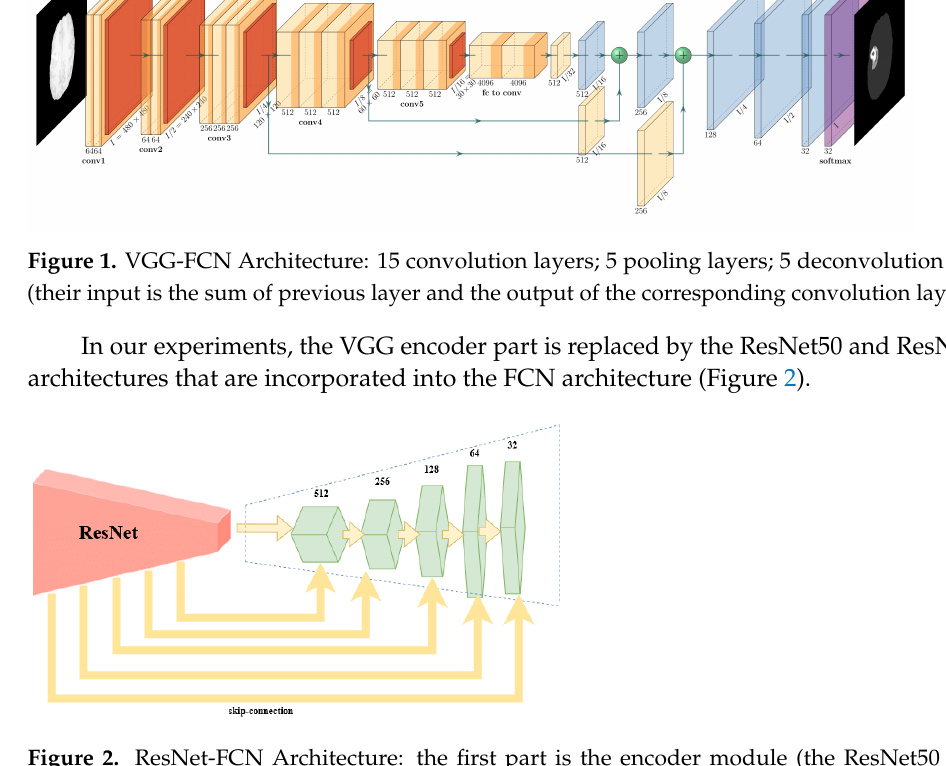
Figure 2. ResNet-FCN Architecture: the first part is the encoder module (the ResNet50 or the ResNet101 architectures) and the second part is the 5-times